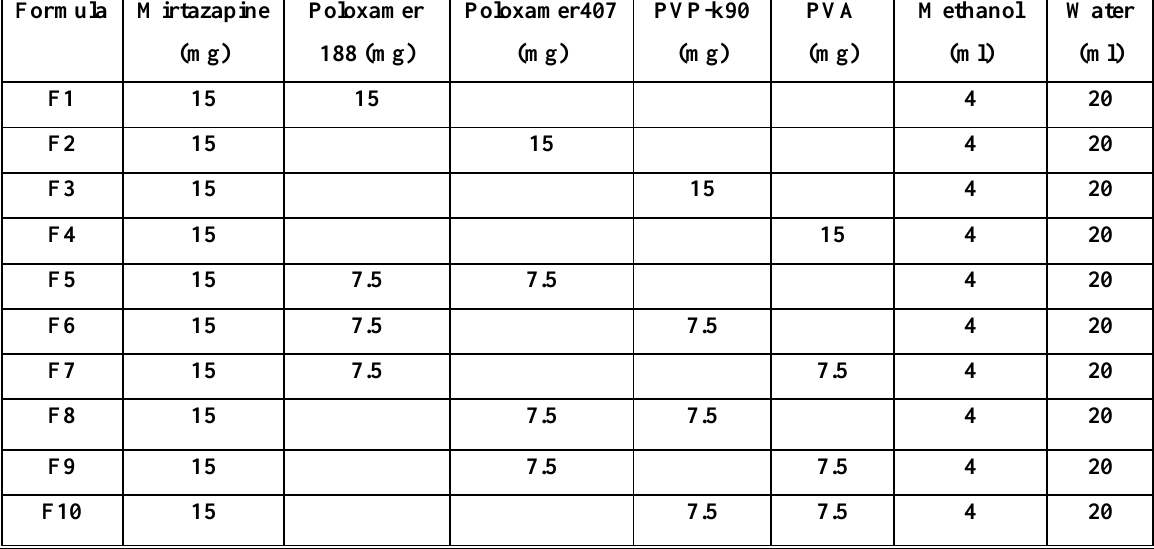
Table1. Composition of mirtazapine nanosuspension using different stabilizers at drug: stabilizer ratio 1:1.